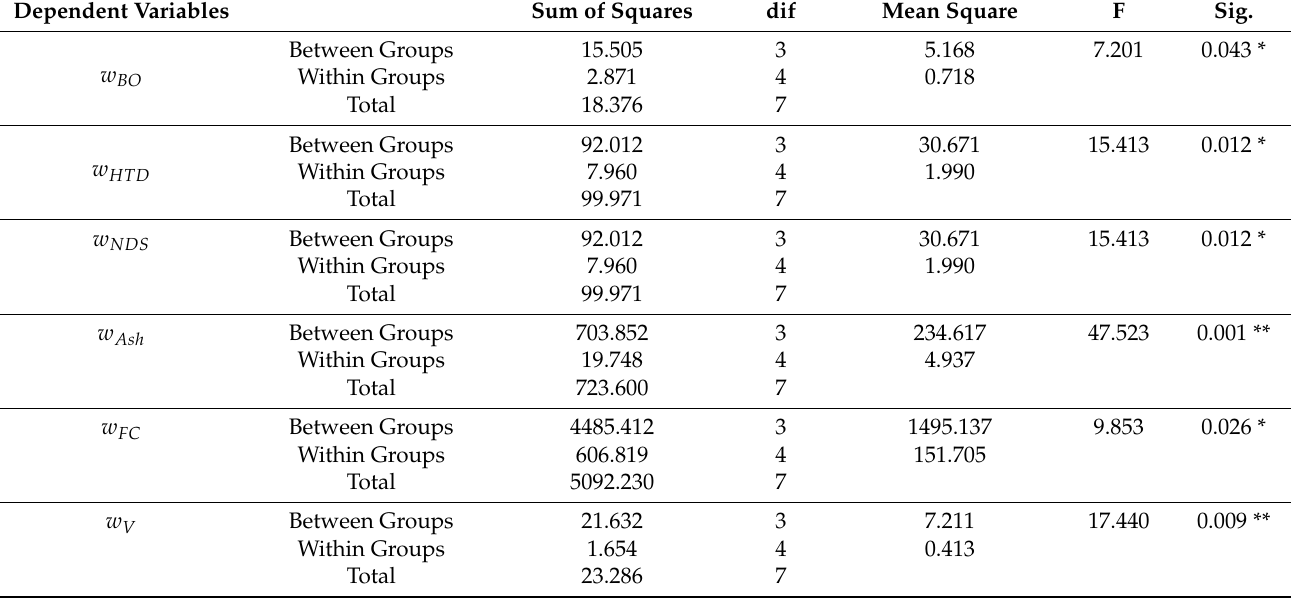
Table 3. One–way ANOVA on the effect of aqueous phase recycling on hydrothermal degradation and oil formation